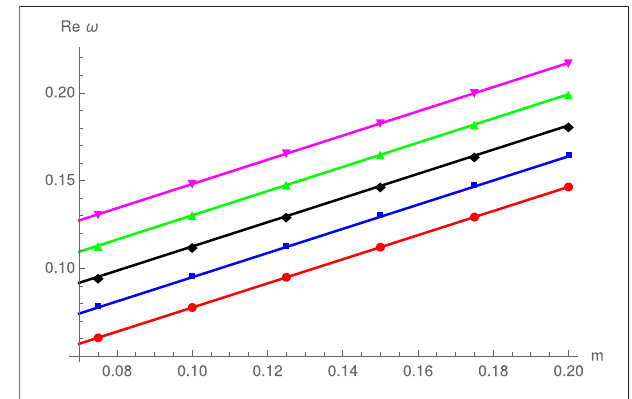
FIGURE 6 | First ten QNFs of the Dirac fi eld with mass m (cid:1) 1/10 propagating in the 2D black hole (2) of radius r + (cid:1) 70.